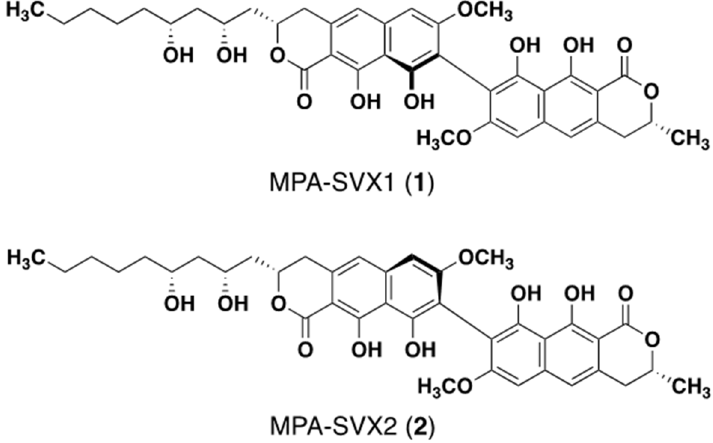
Figure 5. Structures of the M -form MPA-SVX1 ( 1 ) and P -form MPA-SVX2 ( 2 ).